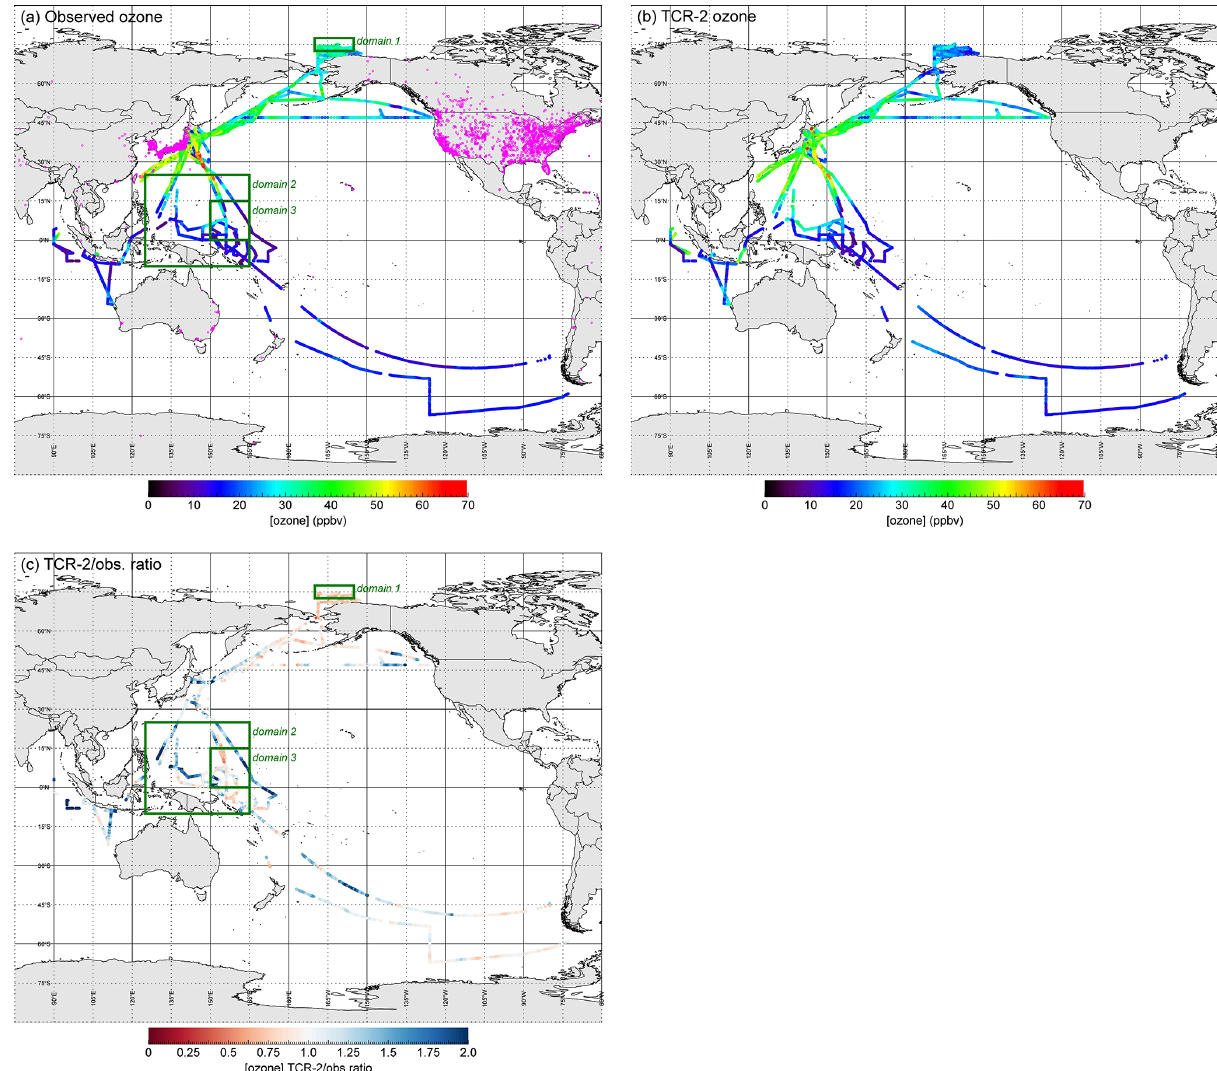
Figure 1. Geographical distributions from (a) observed hourly O 3 mixing ratios ( N = 11666) on R/V Mirai during 24 research cruise legs in 2012–2017 and (b) those from reanalysis (TCR-2) of data along R/V Mirai cruise track; (c) reanalysis / observation ratios (TCR-2/obs) for O 3 mixing ratios. In (a) stationary points of TOAR data set are plotted (magenta dots). In (a) and (c) , three green rectangles show focused domains in the Arctic (domain 1, 72.5–77.5 ◦ N, 190–205 ◦ E) and two in the western Pacific equatorial region (domain 2, 10 ◦ S to 25 ◦ N, 125–165 ◦ E; domain 3, 0–15 ◦ N, 150–165 ◦